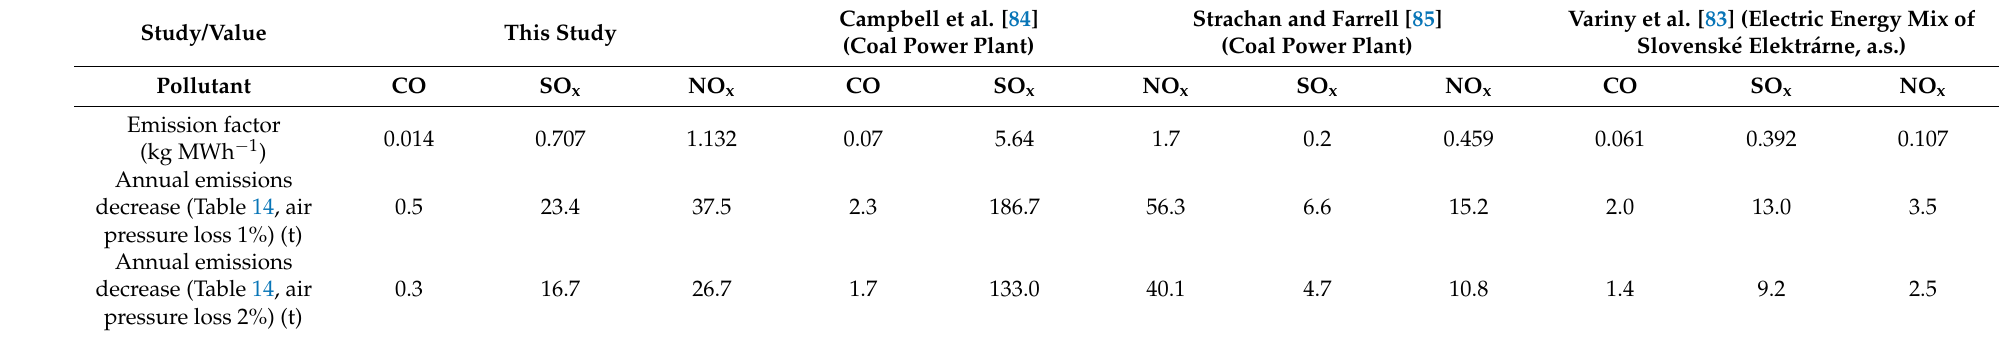
Table 16. Decrease in annual emissions of other major gaseous pollutants resulting from ACH